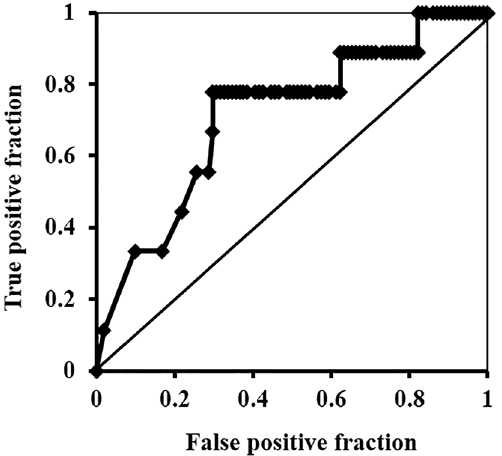
Figure 3. ROC curve of antimullerian hormone for presence of early knee osteoarthritis. The plot of false positive fraction and 1-true positive fraction build curve and area under the curve (AUC) was calculated as